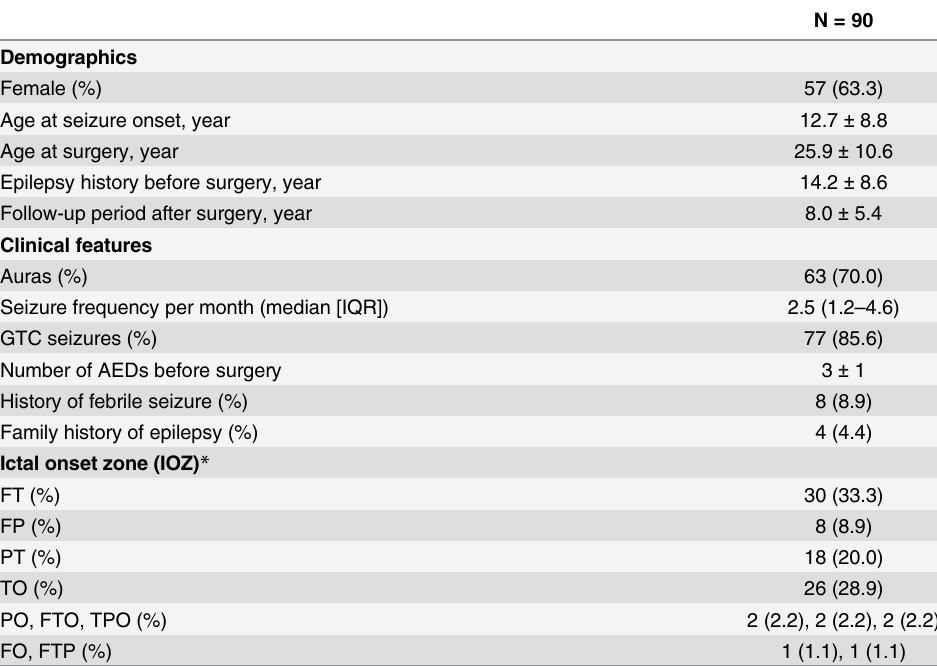
Table 1. Patient